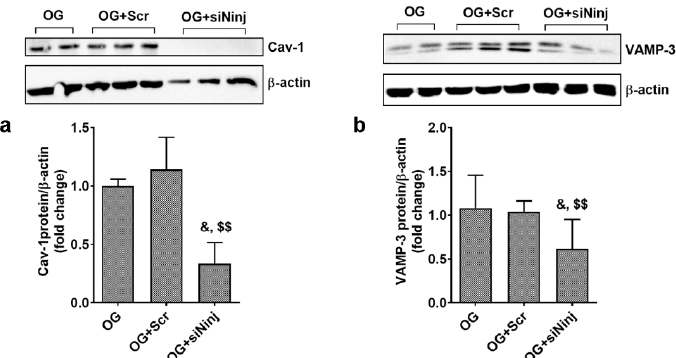
Figure 9. Ninjurin-1 silencing reduces the expression of Cav-1 and VAMP-3 in ECs exposed to oscillating glucose (OG). Cells were transfected with specific siRNA for Ninj-1 (siNinj) or a scrambled siRNA (Scr). At 24 h after transfection, cells were exposed alternatively to 5 mM/25 mM glucose (OG) at every 3 h, for 72 h. ( a , b ) Protein expression of Cav-1 ( a ) and VAMP-3 ( b ) in EC lysates relative to β -actin (representative blot and densitometric analysis). All data are expressed as fold change versus OG and presented as mean ± SD. & p < 0.05 vs. OG; $$ p < 0.01 vs. OG + Scr.